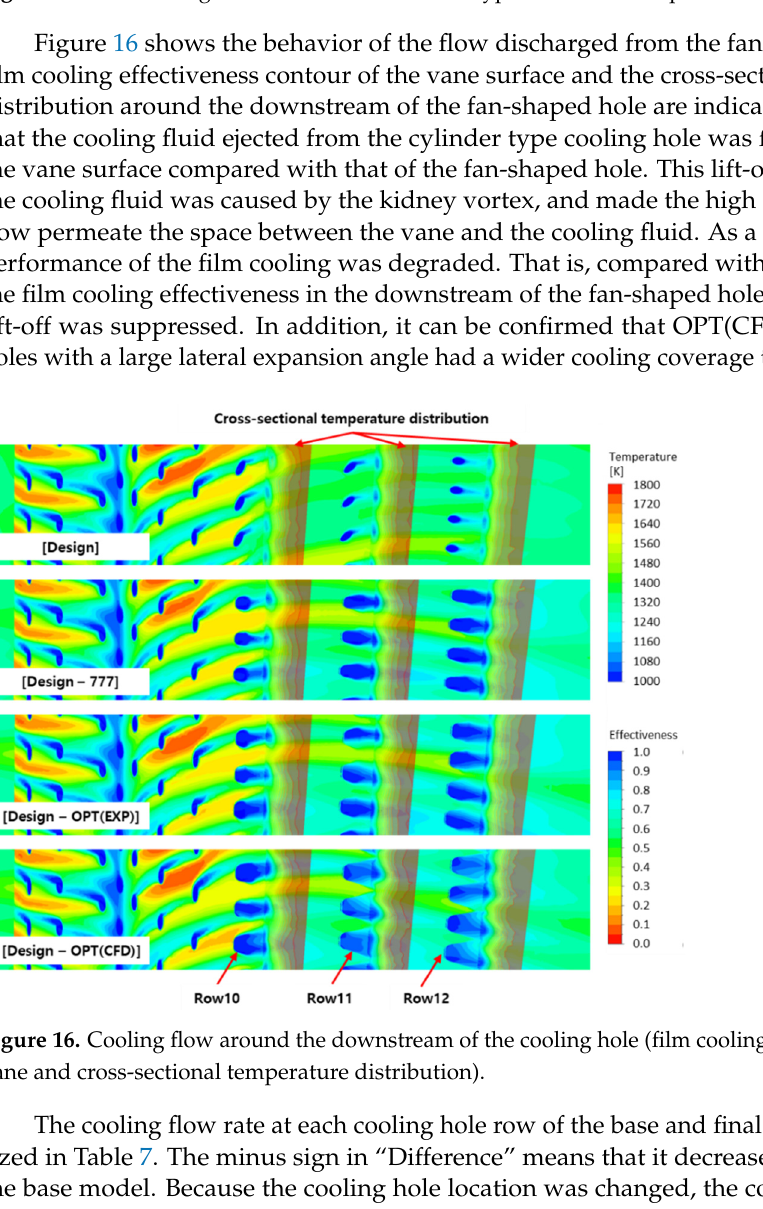
Figure 15. Film cooling effectiveness for the three types of the fan-shaped hole.